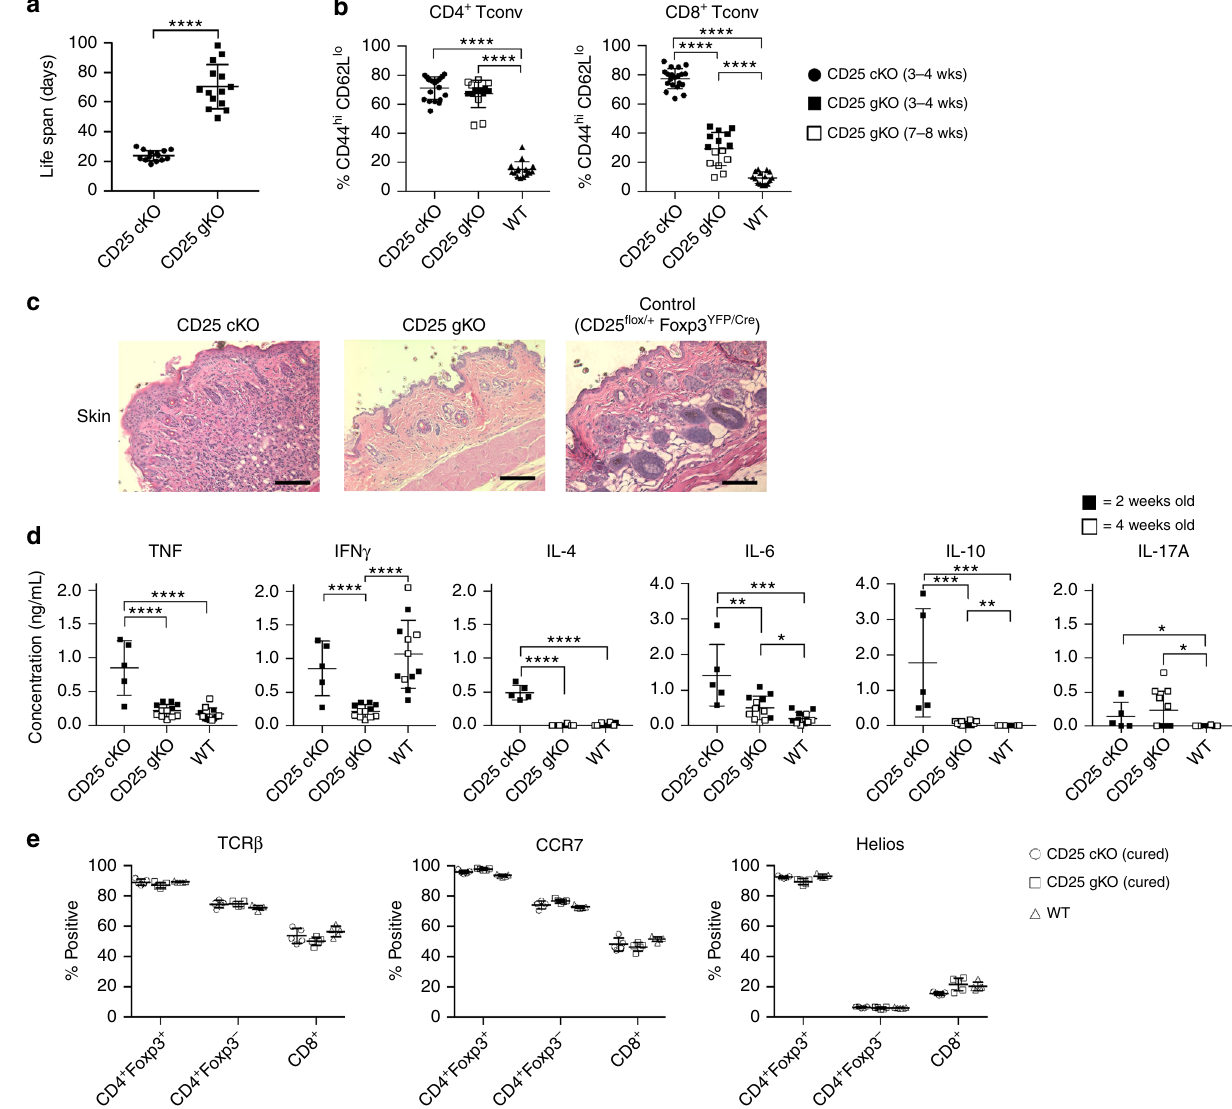
Fig. 1 Lethal autoimmunity in CD25 Treg-targeted conditional and CD25 germline knockout mice. a Lethal autoimmune disease occurs in both CD25 fl ox/Foxp3-YFP/Cre mice (designated CD25 cKO ) and CD25 gKO mice, and is accelerated in the former. Life span refers to time until animals died spontaneously or developed clinical complications for which euthanasia was indicated ( n = 14 mice per genotype). b Percentages of CD4 + and CD8 + T conventional (Tconv) cells from the indicated mice expressing a CD44 hi CD62L lo phenotype, evaluated by ex vivo fl ow cytometry ( n = 15 – 20 mice per genotype). c Representative H&E-stained dorsal skin sections from the indicated mice (magni fi cation ×200, scale bar: 100 μ m). d After stimulation with anti-CD3/CD28, cytokine production by splenocytes from the indicated mice was determined by bead capture assay ( n = 5 – 12 mice per genotype). e Thymic selection based on expression of TCR β , CCR7, and Helios was evaluated among single positive subsets from the indicated mice at 12 – 14 days of age ( n = 5 mice per genotype). Each point represents an individual mouse ( a , b , d , e ; mean ± SD). * p < 0.05, ** p < 0.01, *** p < 0.001, **** p < 0.0001 (two-tailed Student ’ s t test). Data are pooled from ( a , b , d , e ) three independent were reduced by 15 and 30% in CD25 cKO and CD25 gKO mice, likely a direct result of the absence of IL-2R signaling in the respectively (Fig. 2b). The proportion of pSTAT5 + cells was similarly reduced for CD25 cKO and CD25 gKO Foxp3 + thymo- periphery rather than an effect within the thymus. cytes (Fig. 2c, d, left panels), although lower pSTAT5 levels were observed in CD25 gKO mice when measured by normalized MFI, a pattern which was identical in recipient cells from “ cured ” mice (Fig. 2d, right panel). This pSTAT5 was associated with Foxp3 + CD25 + cells from WT and CD25 cKO mice, albeit on a lower fraction of cells for the latter (Fig. 2c, right panel), a result con- sistent with IL-2-dependent STAT5 activation in these developing Tregs. In contrast, Foxp3 + pSTAT5 + thymocytes from CD25 gKO mice were exclusively CD25 neg pSTAT5 lo . Although CD25 gKO